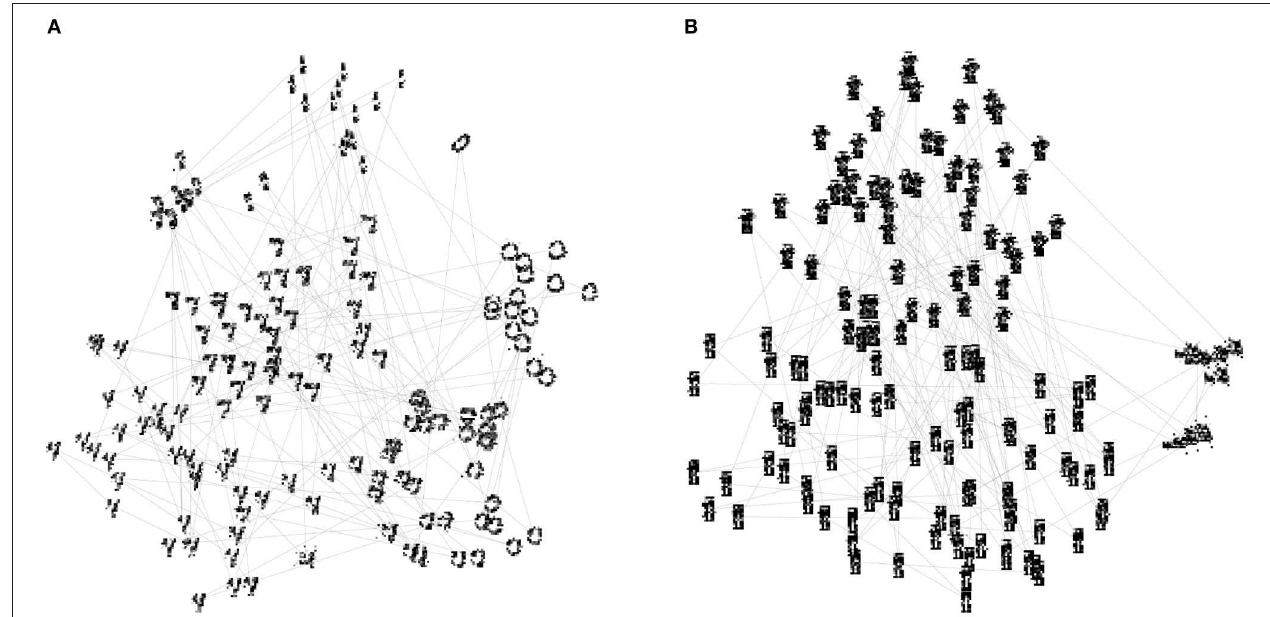
FIGURE 7 | Generated images during guided dreaming. The visible state space, along with the position of the generated images within it, was projected to two dimensions using t-SNE (Maaten and Hinton, 2008). The thin lines connect consecutive samples. (A) rMNIST; (B)